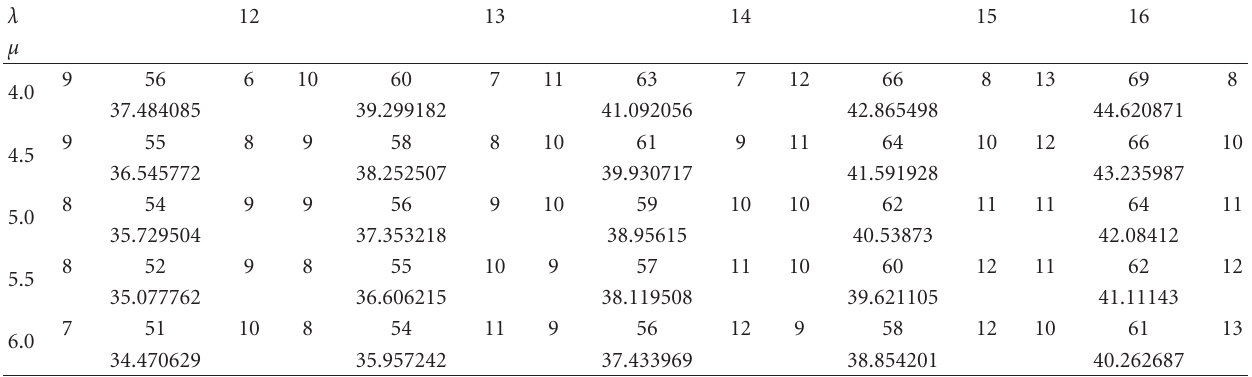
Table 1: Optimal values corresponding to various demand rates and the replenishment rates ( γ = 1 . 4, β = 1 . 3, α = 4, p = 0 . 85).